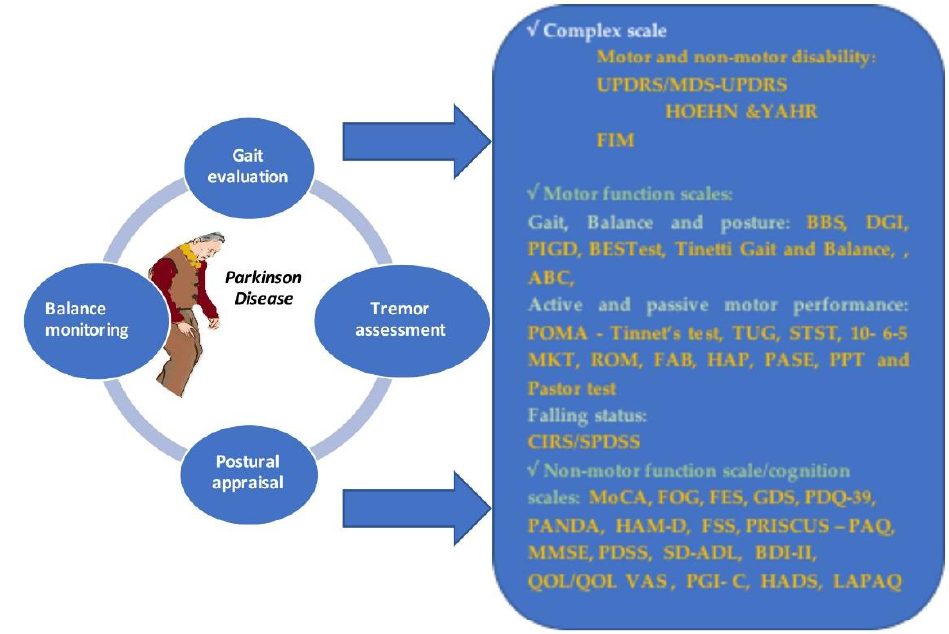
Figure 2. Motor and non-motor instruments used in PD. UPDRS: Unified Parkinson’s Disease Rating Scale; ADL: Activities of Daily Living; PDQ-39: 39-item Parkinson’s Disease Questionnaire; PANDA: Parkinson Neuropsychometric Dementia Assessment; HAM-D: Hamilton Depression Rating Scale; PRISCUS-PAQ: PRISCUS-Physical Activity Questionnaire; Parkinson’s Disease Sleep Scale 2; MMSE: Mini Mental Status Examination; BBS: Berg Balance Scale; FIM: Functional Independence Measure; 6 MKT: 10 / 6 Meter Walk Test; HAP: Human Activity Profile; FSS: Fatigue Severity Scale; ROM: Range of Motion; SPPB: Short Physical Performance Battery; HFLEX: hip flexion range of motion; HABD: hip abduction range of motion; FOG: Freeze of Gait questionnaire; TUG protocol: Time Up and Go test; BESTest: Balance Evaluation System Test; MoCA: Montreal Cognitive Assessment; GDS: Geriatric Depression Scale; PPT: Physical Performance Test; CIRS: Cumulative Illness Rating Scale / SPDDS; HADS: Hospital Anxiety and Depression Scale; LAPAQ-LASA: Physical Activity